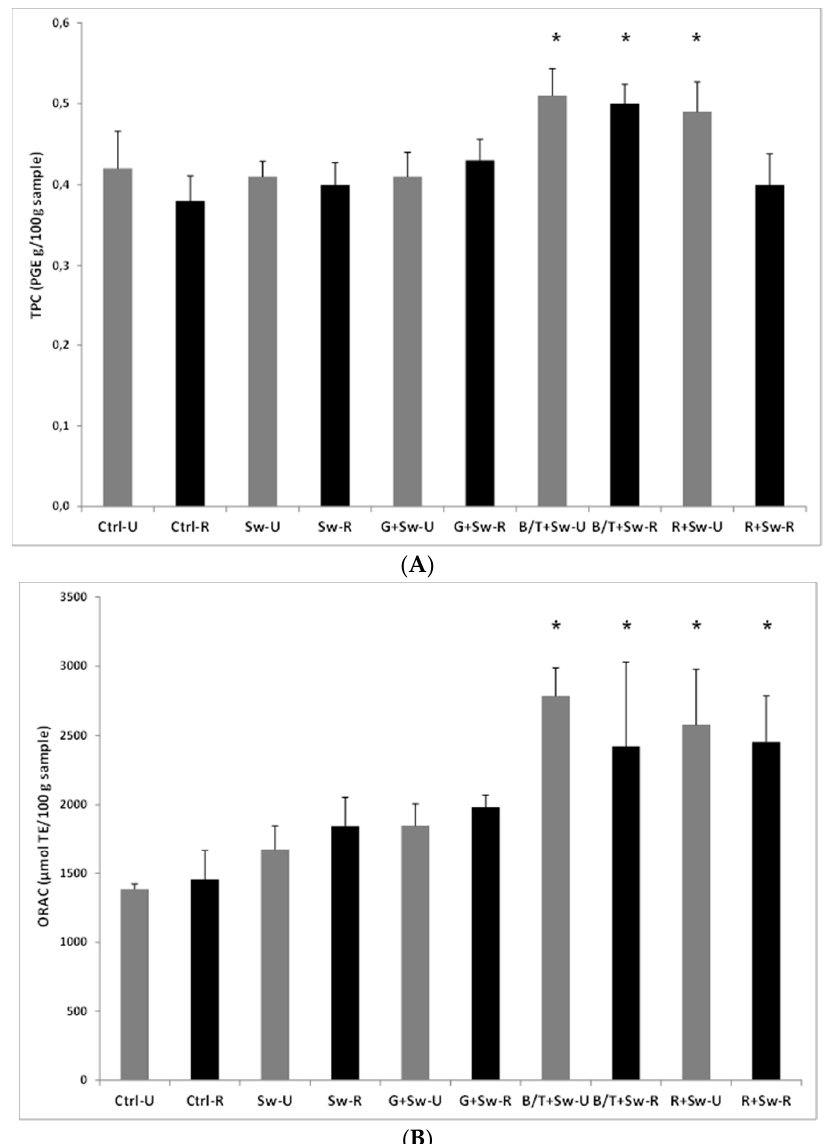
Figure 4 . (A ) TPC and ( B ) ORAC values ( μ mol TE in 100 g sample) of roasted (R) and unroasted (U) rye snacks containing different flavorings, i.e., 1% garlic (G), 0.5% basil (B) + 3% tomato (T) or 0.5% rosemary (R) powder. All groups contained rye mix, 0.8% Himalayan salt and 2.1% seaweed extract (Sw, batch B200314), except the control group, which only contained rye mix and 0.8% Himalayan salt (Ctrl). Data are expressed as mean ± SD of four independent experiments. * p < 0.05 vs. Sw-U and Sw-R groups.